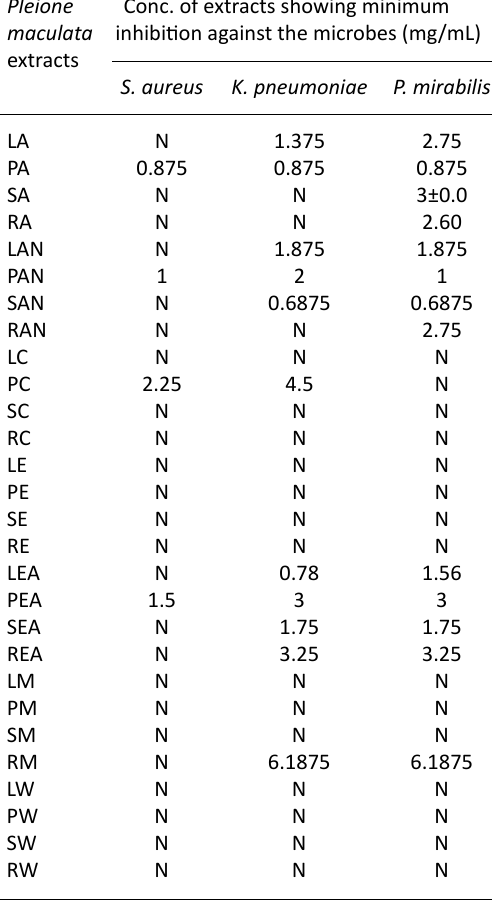
table 8. MIC value of the effective extracts of P. maculata against the clinical isolates Pleione Conc. of extracts showing minimum maculata inhibition against the microbes (mg/mL)